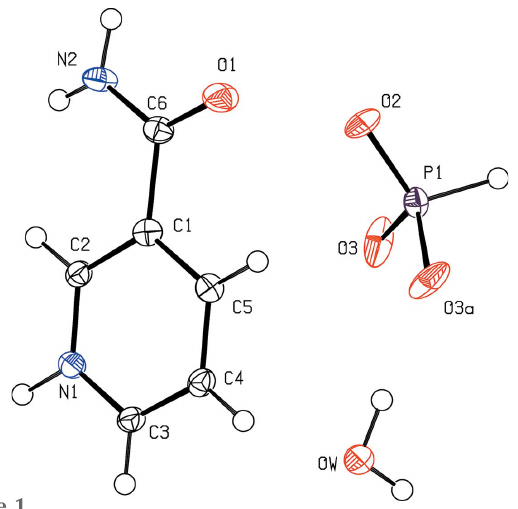
C4—H1 c 4 (cid:2) (cid:2) (cid:2) O1 iii . The water oxygen atom is also an acceptor